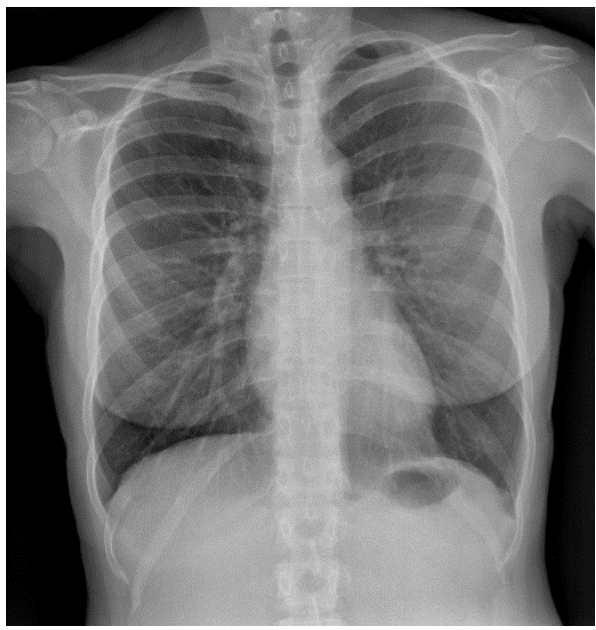
Figure 1. Pulmonary radiography of an uninfected